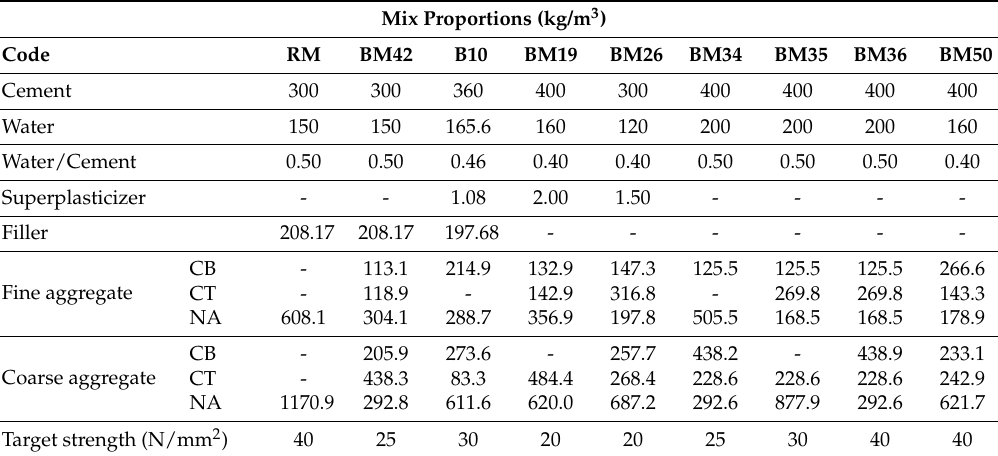
Table 2. Concrete composition.